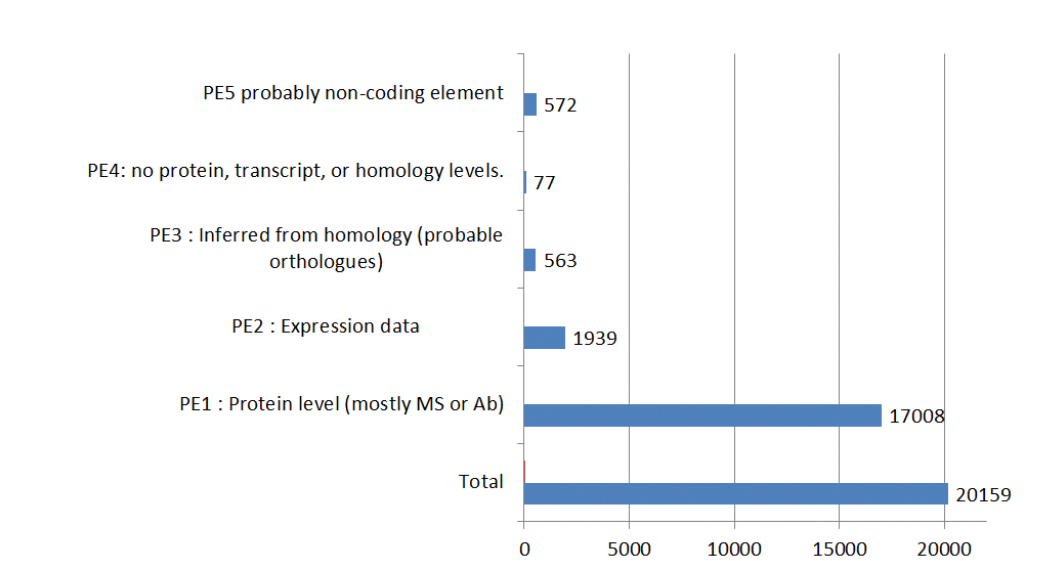
Figure 4. Protein existence codes and their occupancy statistics from